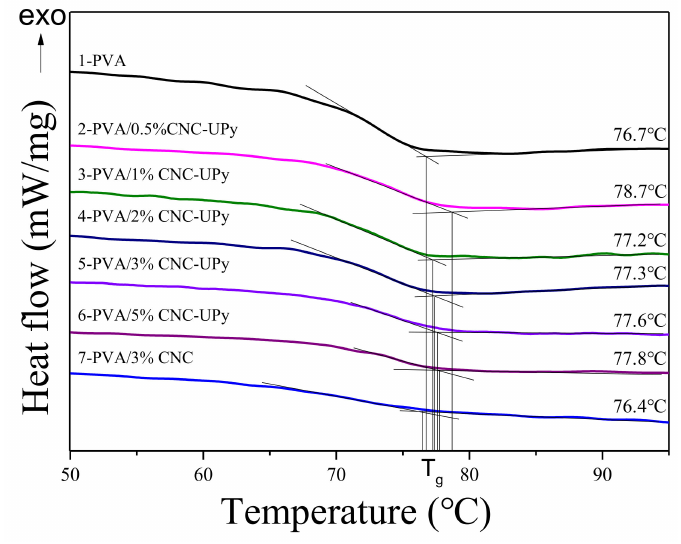
Figure 7. DSC curves of di ff erent PVA composite